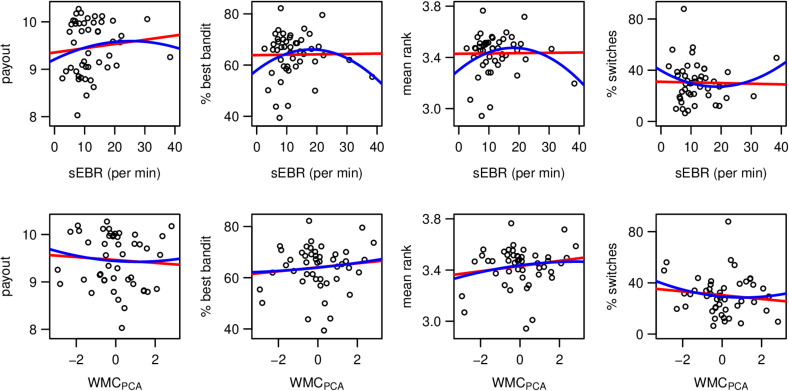
Test for an inverted-U relationship between choice behavior and DA baseline.Choice behavior was assessed by four model-free choice variables (payout, %bestbandit, meanrank, %switches). DA baseline function was assessed by the two DA proxies spontaneous eyeblink rate (sEBR) and working memory capacity (WMC). For the latter, the first principal component across three different WMC tasks was used, denoted by WMCPCA. Each plot shows two regression lines that were fitted to the data, one for the “linear model” (red line) and one for the “quadratic model” (blue line). Note that data from a pilot study and the placebo condition of the main study were combined for this analysis to increase the sample size to n=47. β: softmax parameter; φ: exploration bonus parameter; ρ: perseveration bonus parameter.